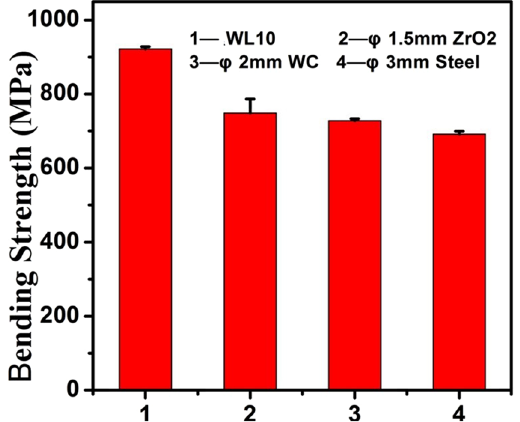
Figure 3. 3PB bending strength of different ball SMATed WL10 samples.